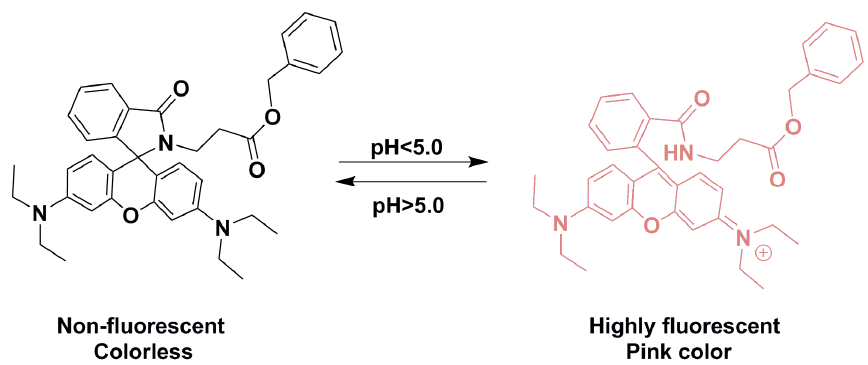
O (2:3, v/v, pH 5.95) in the 2